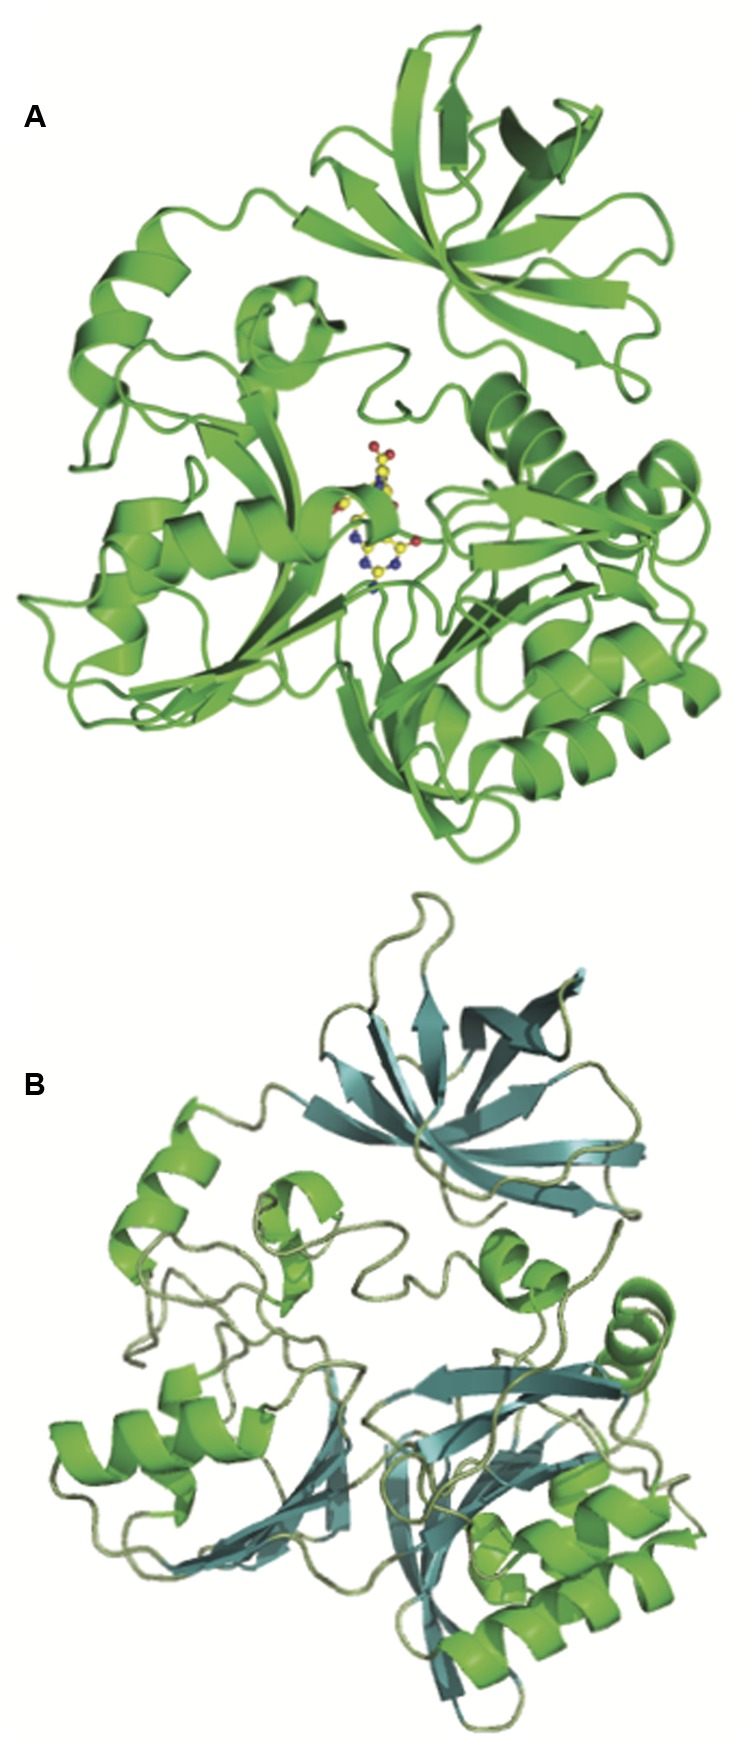
Structural similarity of the glycine cleavage T-protein and the DMSP demethylase (DmdA). Crystal structures of the (A) glycine cleavage T-protein from Thermotoga maritima (Lee et al., 2004) (PBD ID:1WOO) and (B) the DmdA monomer from P. ubique (Schuller et al., 2012) showing the shared tri-domain structure.